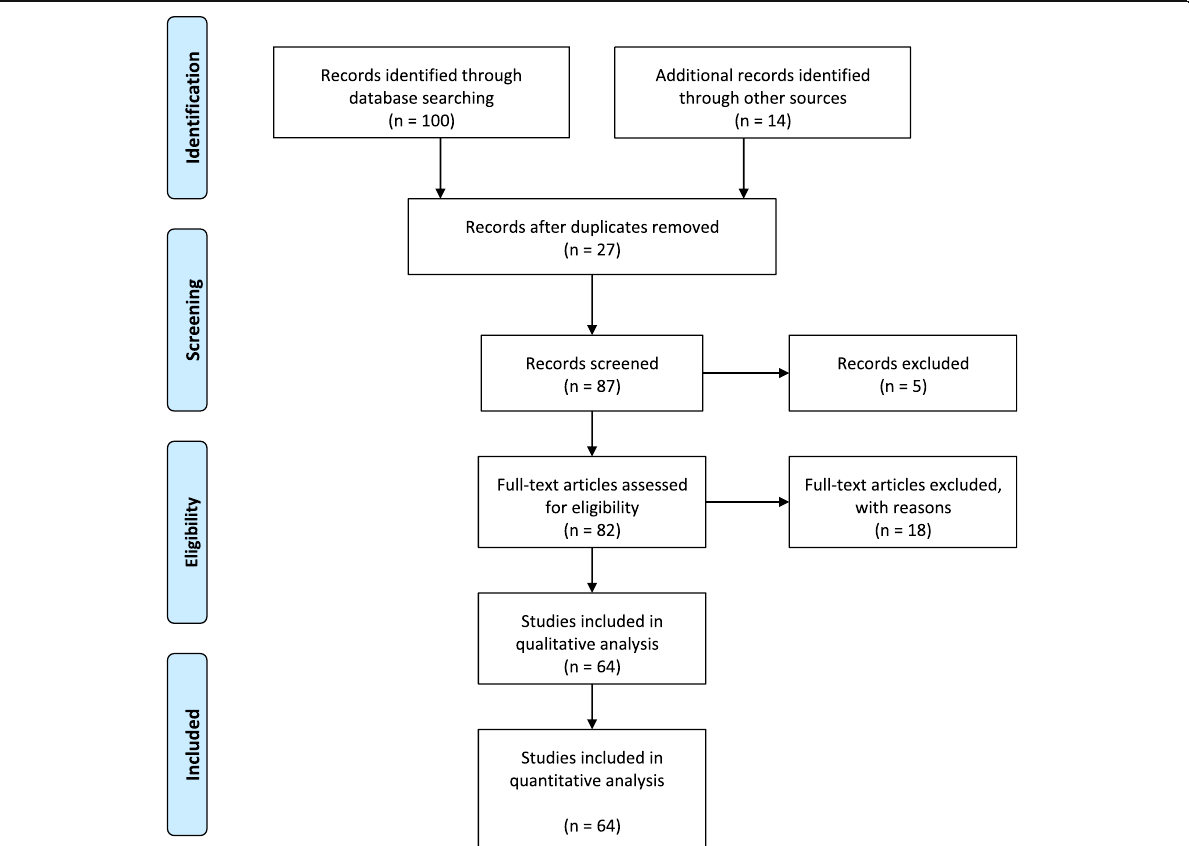
Fig. 1 PRISMA flowchart for the process of study selection. Abbreviations: Preferred Reporting Items for Systematic Reviews and